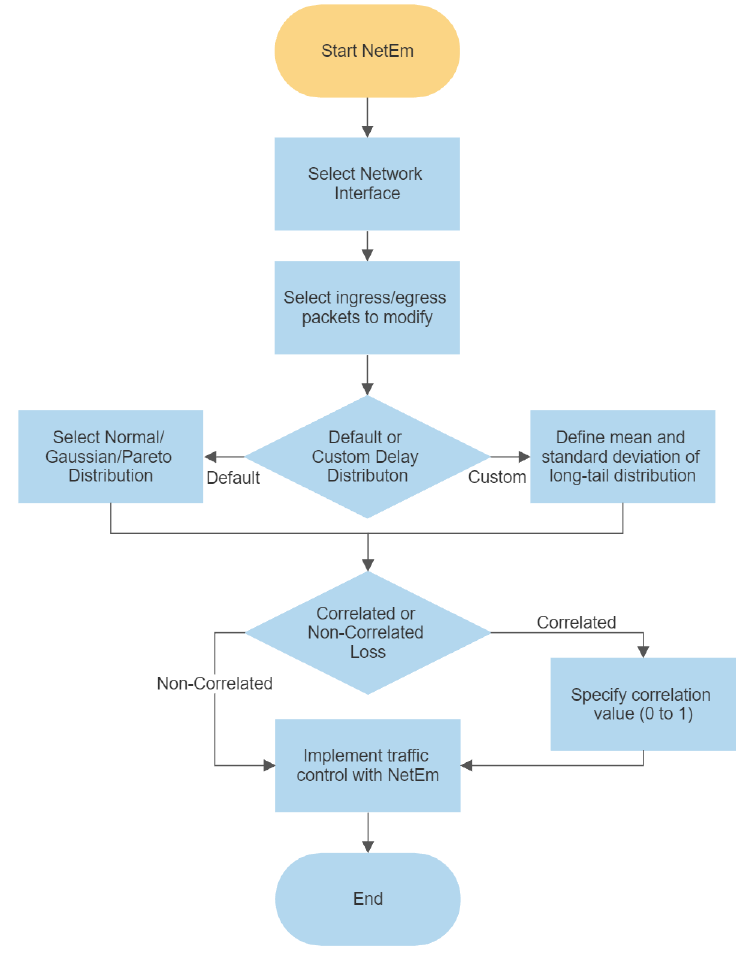
Figure 3. Bespoke NetEm Process Flowchart.